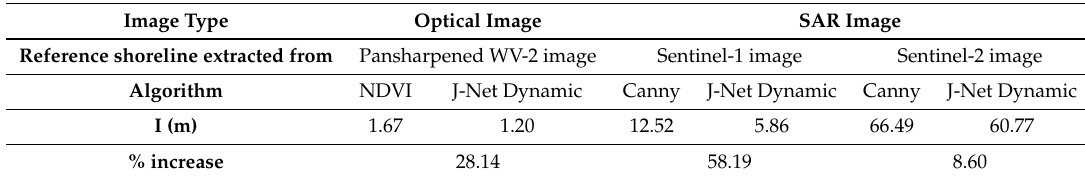
Table 2. I Index values. Comparisons.